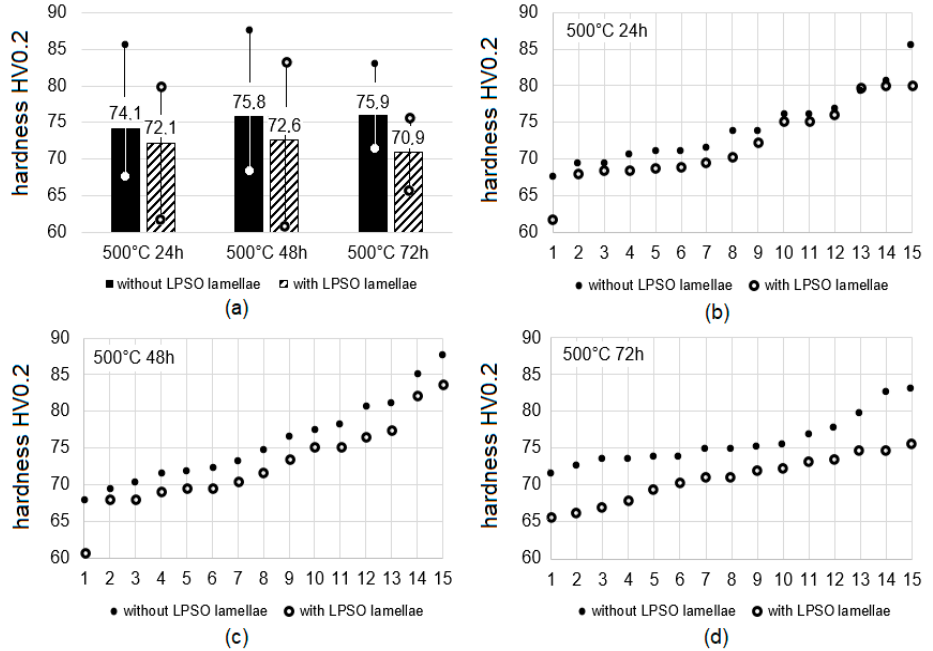
Figure 8. Hardness HV0.2 of grains with and without matrix LPSO lamellae influence by solution heat treatment time at 500 °C: mean values with minimum and maximum value ( a ), values sorted according to their size at 24 h ( b ), 48 h ( c ) and 72 h ( d ).